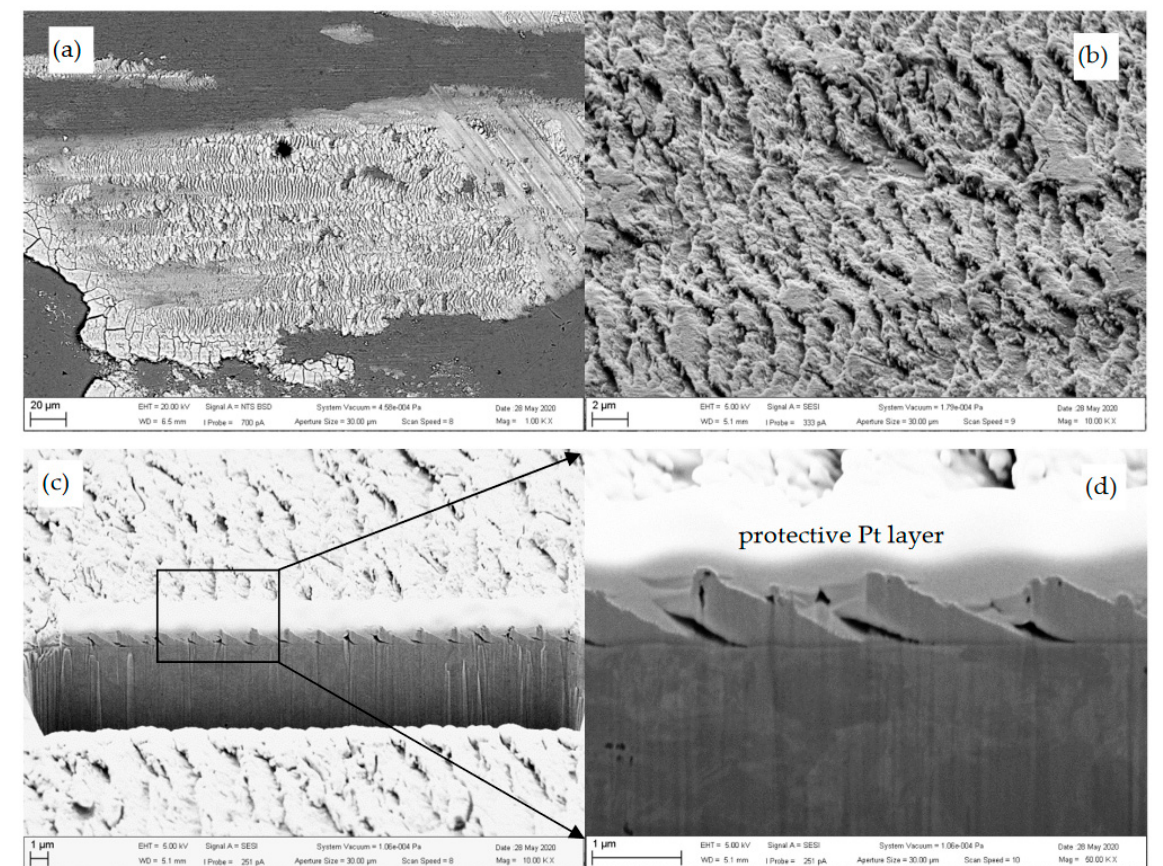
Figure 10. Tribo-film patches in the wear track of W-C:H 0C 2 H 2 -15H 2 coating after friction test up to 1100 m: ( a ) general view with the periodic wavy relief, ( b ) detail of the patch topography, ( c ) FIB cross-section and ( d ) detail of the cross-section of tribo-film patch.